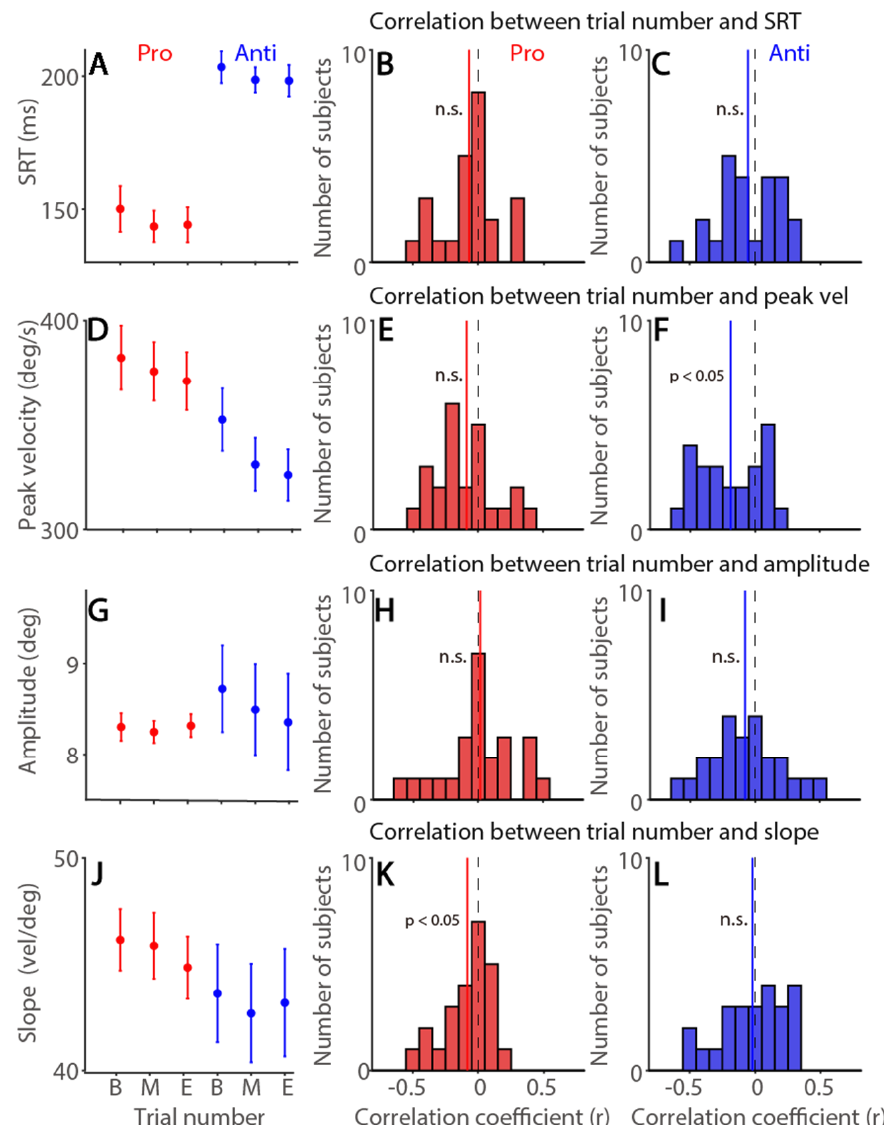
Figure 6. Time-on-task effects on saccade latency and metrics in the pro- and anti-saccade task. ( A ) Saccade reaction times (SRTs) at different trial number conditions. ( B , C ) Distribution of correlation coefficients for the relationship between trial number and SRT in the pro-saccade ( B ) and anti-saccade ( C ) task for all subjects ( n = 24). ( D ) Saccade peak velocity at different trial number conditions. ( E , F ) Distribution of correlation coefficients for the relationship between trial number and saccade peak velocity in the pro-saccade ( E ) and anti-saccade ( F ) task for all subjects. ( G ) Saccade amplitude at different trial number conditions. ( H , I ) Distribution of correlation coefficients for the relationship between trial number and saccade amplitude in the pro-saccade ( H ) and anti-saccade ( I ) task for all subjects. ( J ) Main sequence slope (peak velocity/amplitude) at different trial number conditions. ( K , L ) Distribution of correlation coefficients for the relationship between trial number and slope in the pro-saccade ( K ) and anti-saccade ( L ) task for all subjects. The error bars represent ± standard error range (across participants). The vertical black dashed line represents a zero value of the correlation coefficient (r = 0), and the vertical colored line represents the mean value of the correlation coefficient. Visual: visually guided saccade task. Memory: memory-guided saccade task. B: begin, M: mid, E: end. SRT: saccade reaction times. n.s.: not